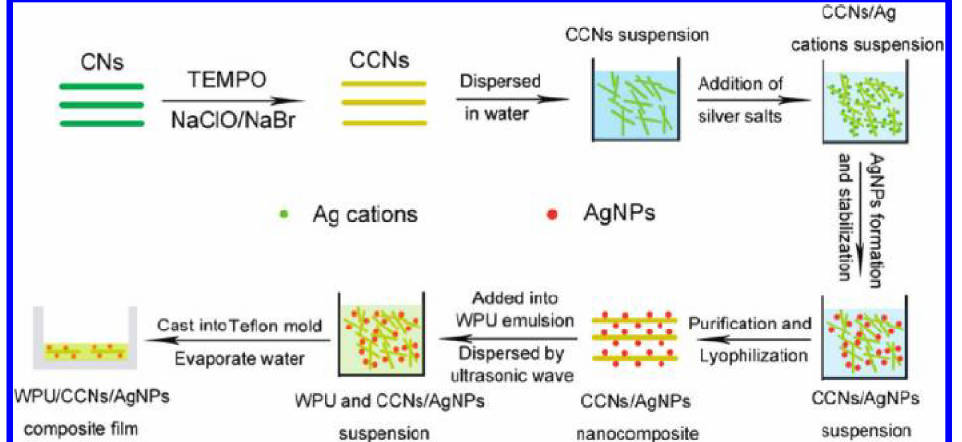
Figure 2. Preparing the CCNs/AgNP composite and incorporation into waterborne polyurethane [47]. Copyright © 2012, American Chemical